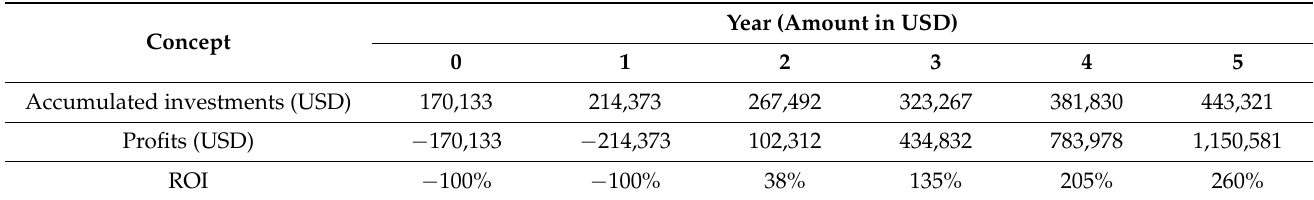
Table 19. ROI for different